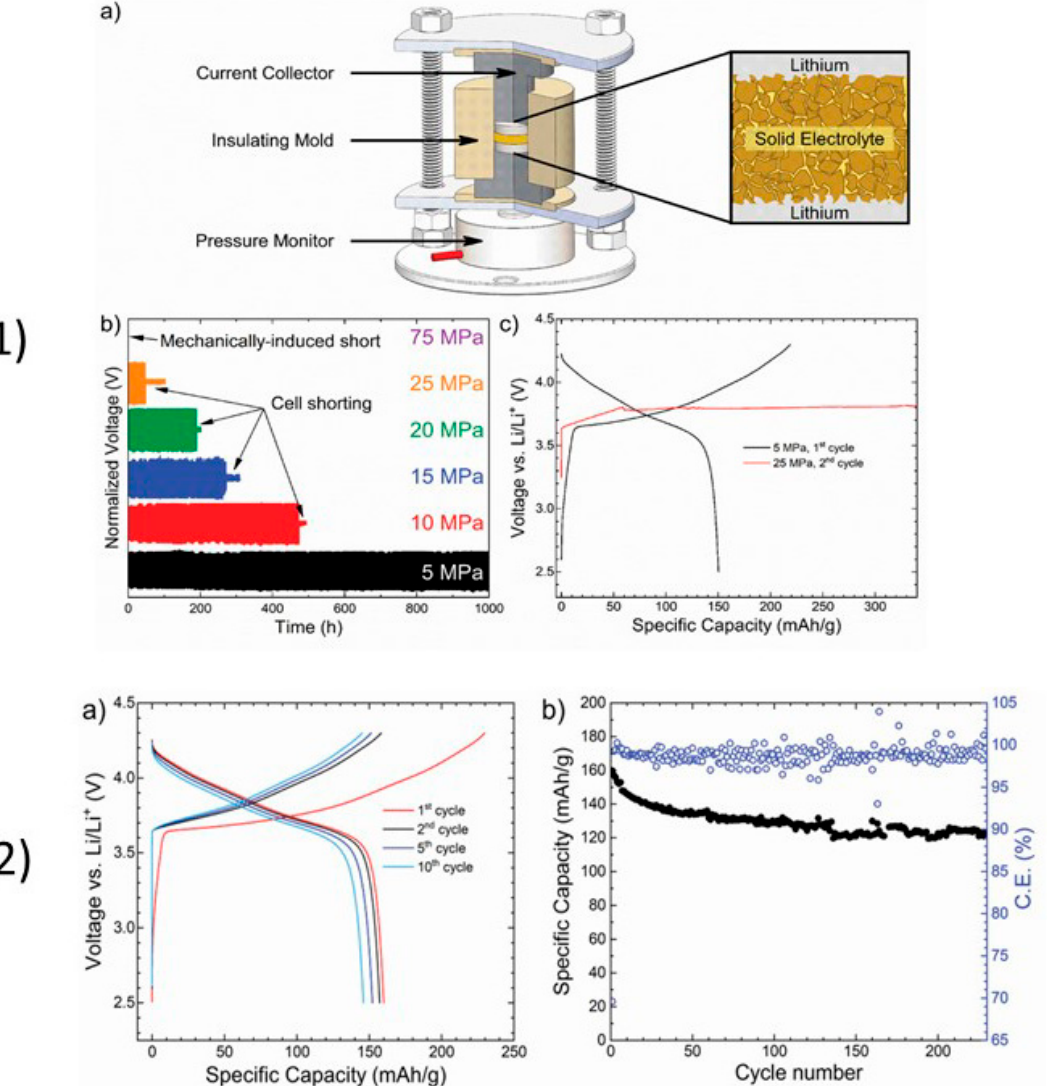
Figure 7. ( 1 ) ( a ) Design of solid-state Li symmetric cell that allows control and monitoring of the pressure during cycling. ( b ) Normalized voltage of Li symmetric cells as a function of the plating and stripping times at di ff erent stack pressures. At 75 MPa, the cell already mechanically short-circuited before cycling began. At 5 MPa, no short-circuit was observed for over 1000 h. ( c ) Voltage profile of a full cell with Li metal anode. The first cycle was run at a stack pressure of 5 MPa. The stack pressure was subsequently increased to 25 MPa before the second cycle, during which the cell short-circuited. ( 2 ) ( a ) Voltage profiles of the 1st, 2nd, 5th, and 10th cycles and ( b ) cycle life of a Li metal | Li 6 PS 5 Cl | LiNbO 3 -coated LiNi 0.8 Co 0.15 Al 0.05 O 2 all-solid-state Li-ion battery cycled at C / 10 and a stack pressure of 5 MPa (black and blue dots are specific capacity and coulombic e ffi ciency data, respectively). No short-circuiting behavior was observed. The average Coulombic e ffi ciency (C.E.) over 229 cycles was 98.86%, and the capacity retention of the cell was 80.9% over 100 cycles. The active material loading was 3.55 mg cm − 2 . Reproduced with permission from [201]. Copyright 2020